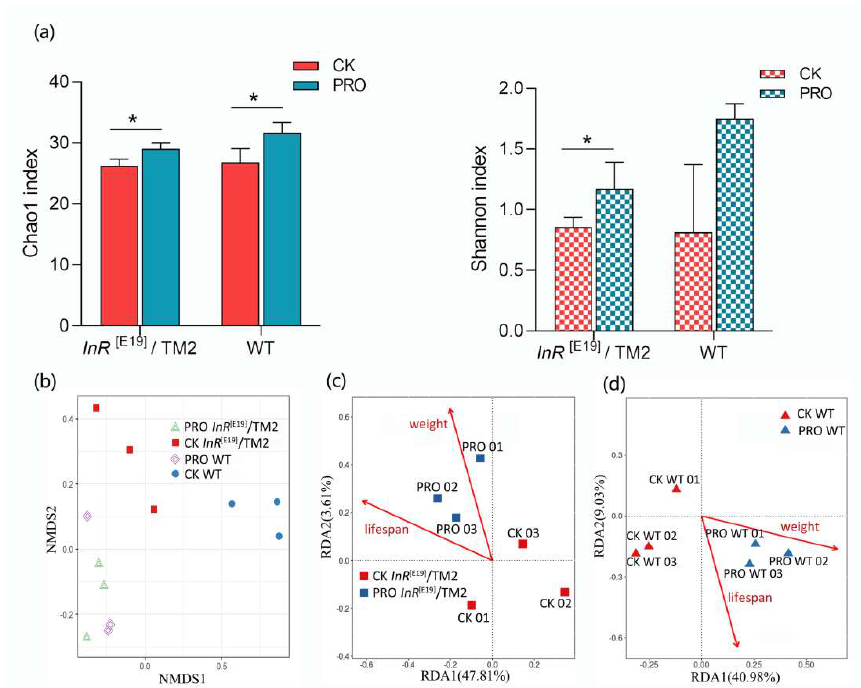
Figure 3. ( a ) Chao1 and Shannon indices indicate intestinal bacterial diversity in all tested samples. Asterisks indicate a significant difference between marked data (* p ≤ 0.05). ( b ) NMDS analysis shows the shifts of the bacterial communities driven by the probiotic combination among all samples. ( c , d ) Redundancy analysis (RDA) analysis shows the relationship between the bacterial communities, lifespan, bodyweight, and probiotic treatment, ( c ) InR [E19] / TM2 group, ( d ) WT group.